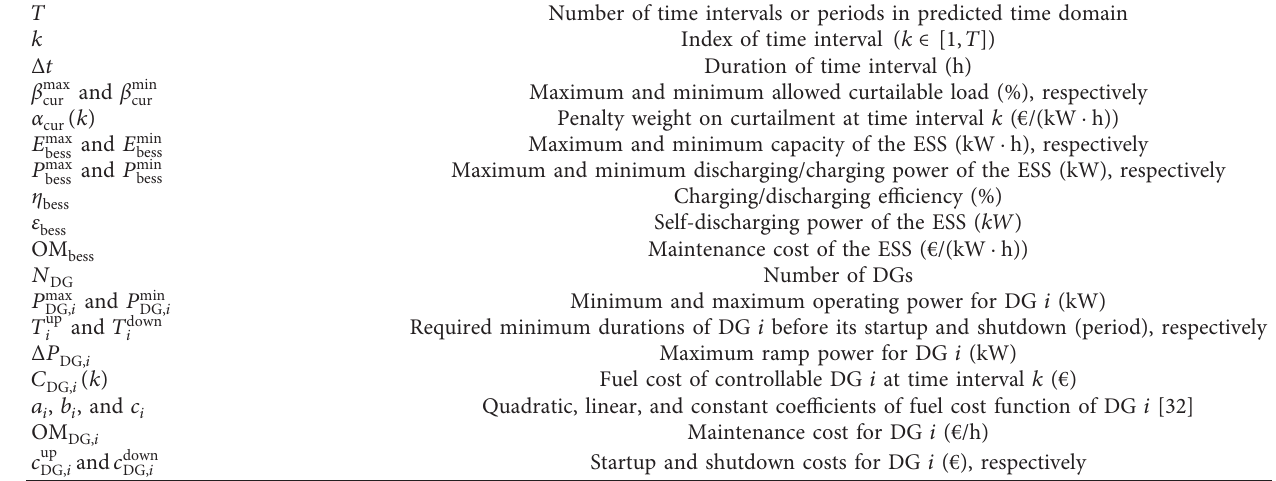
Table 1: System parameters.